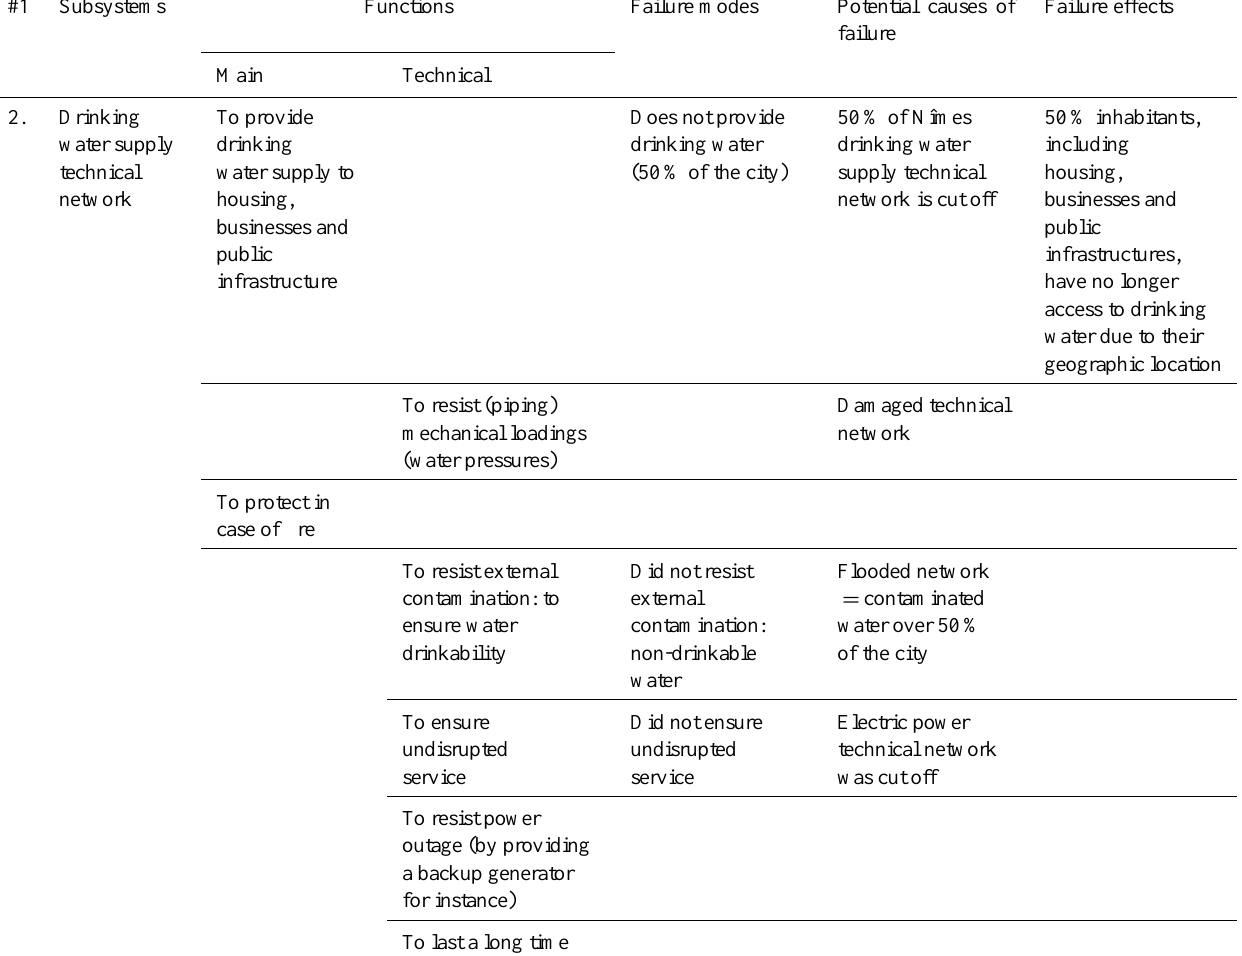
Table 5. FMEA table for Nîmes during the 1988 runoff flooding event: sample of drinking water supply technical networks.